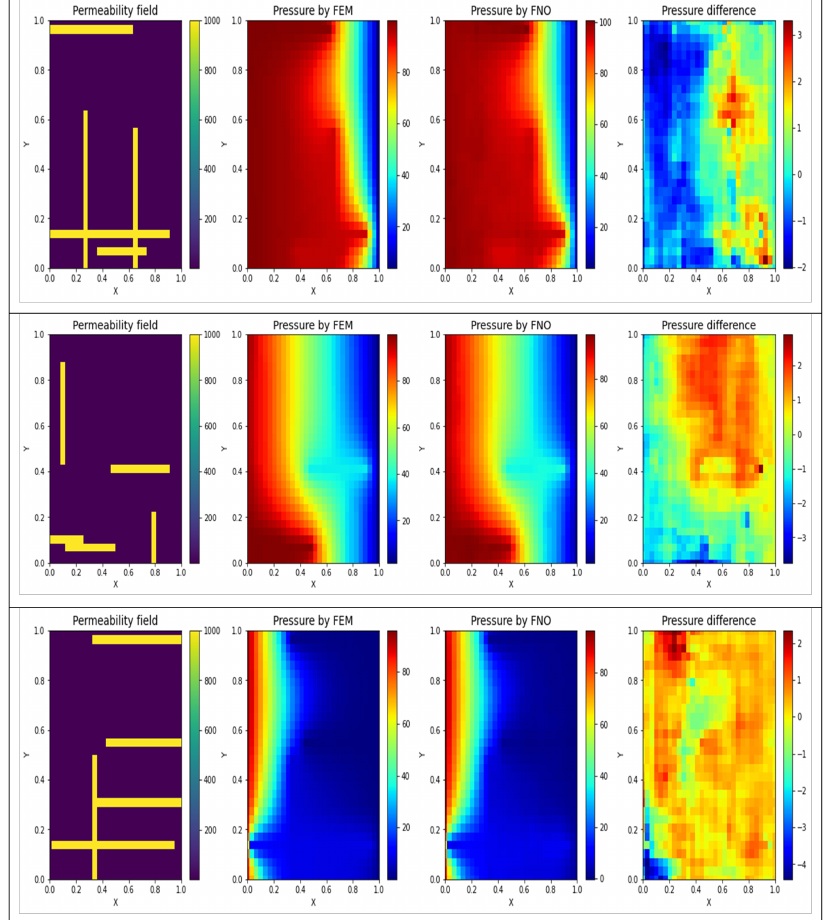
Figure 4. A comparison between the actual pressure distributions and those obtained by FNO for three representative training subset samples. The pressure difference is based on a point-by-point absolute error. Outputs are displayed as rectangles rather than squares due to a scaling issue.